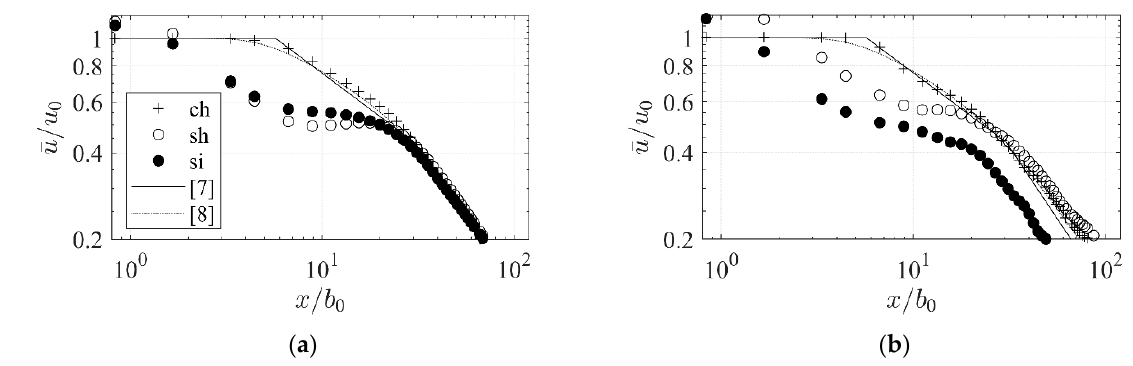
Figure 13. Downstream evolution of the mean streamwise centerline velocity 𝑢(cid:3364)/𝑢 (cid:2868) at 𝑦 = 0 and 𝑧 = ℎ (cid:2868) for ( a ) simula- tion with RANS (kw-SST turbulence model) ( b ) simulation with DES. Analytical models are given for comparison: [7,8].